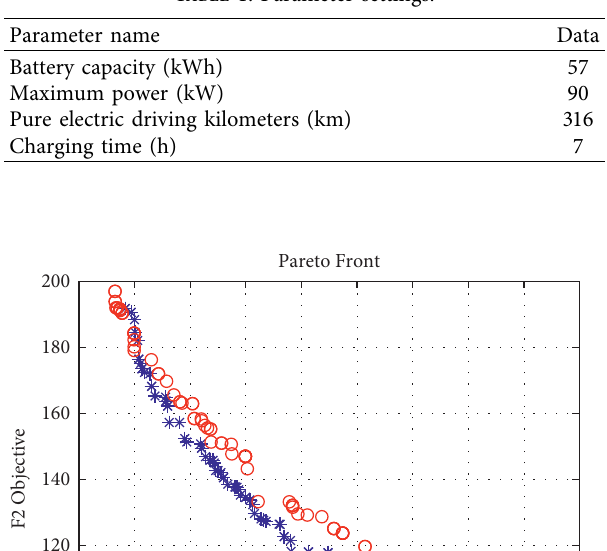
Figure 1: Illustration of a microgrid. Table 1: Parameter settings.